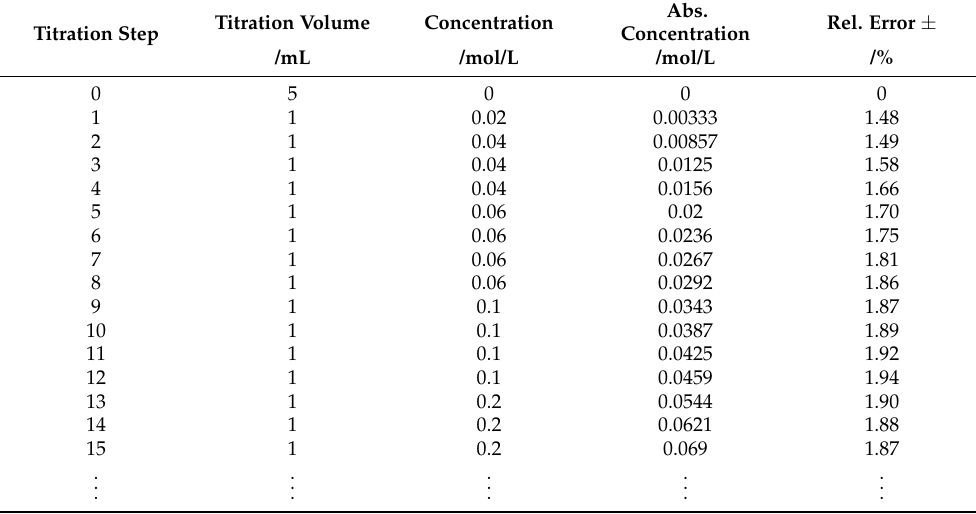
Table 3. exemplary titration